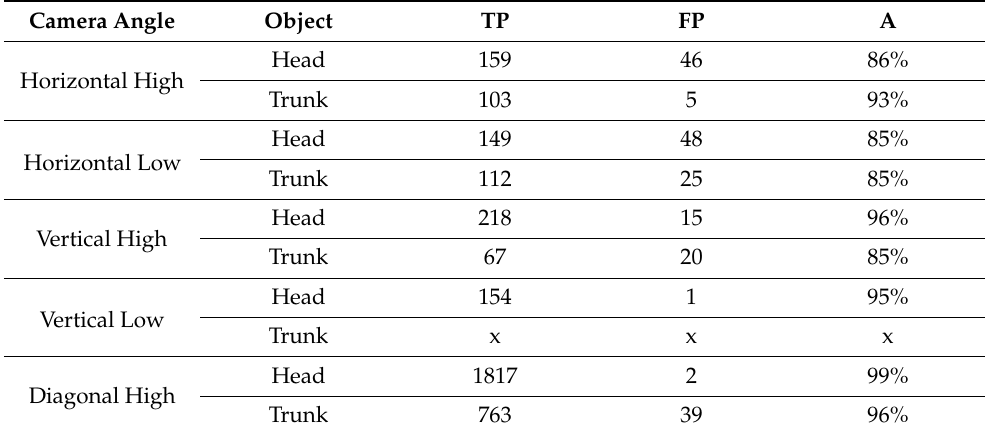
Table 1. Head and trunk detection results for different camera